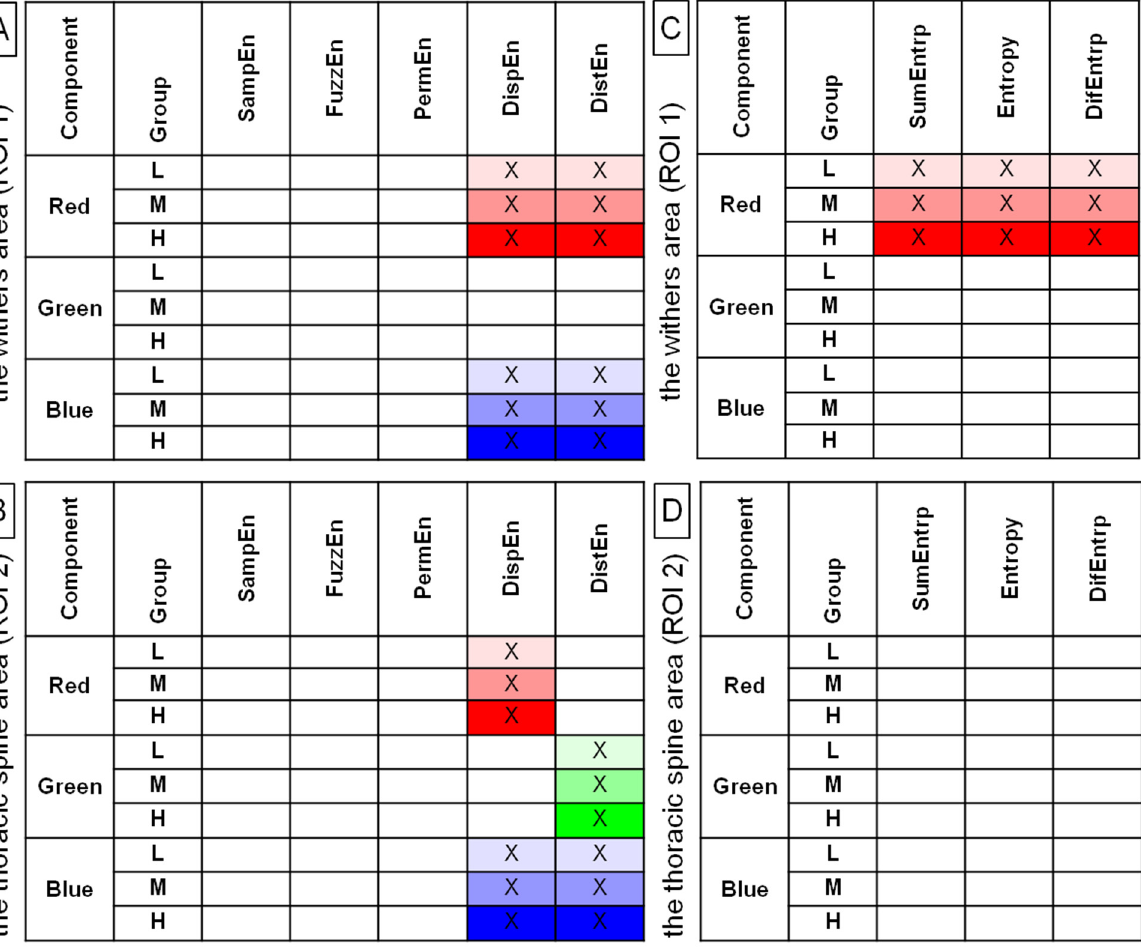
Figure 6. Entropy measures ( A , B ) and selected gray-level run-length matrix features ( C , D ) for examined color components (red, green, blue), which were found to be significantly different between light (L), moderate (M), and heavy (H) rider groups on the post-exercise imaging. Data were presented separately for the withers area (ROI 1) ( A , C ) and the thoracic spine area (ROI 2) ( B , D ). SampEn—two-dimensional sample entropy, FuzzEn—two-dimensional fuzzy entropy, PermEn—two-dimensional permutation entropy, DispEn—two-dimensional dispersion entropy, DistEn—two-dimensional distribution entropy, SumEntrp—summation entropy, entropy, DifEntrp—differential entropy. The measures that differed between rider groups were marked by color (light red, green, blue for L group; moderate red, green, blue for M group; and dark red, green, blue for H group) and by a cross (X).